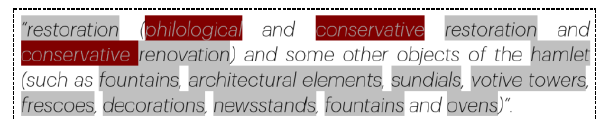
Figure 7. Concepts, relations and properties from the PRGI.